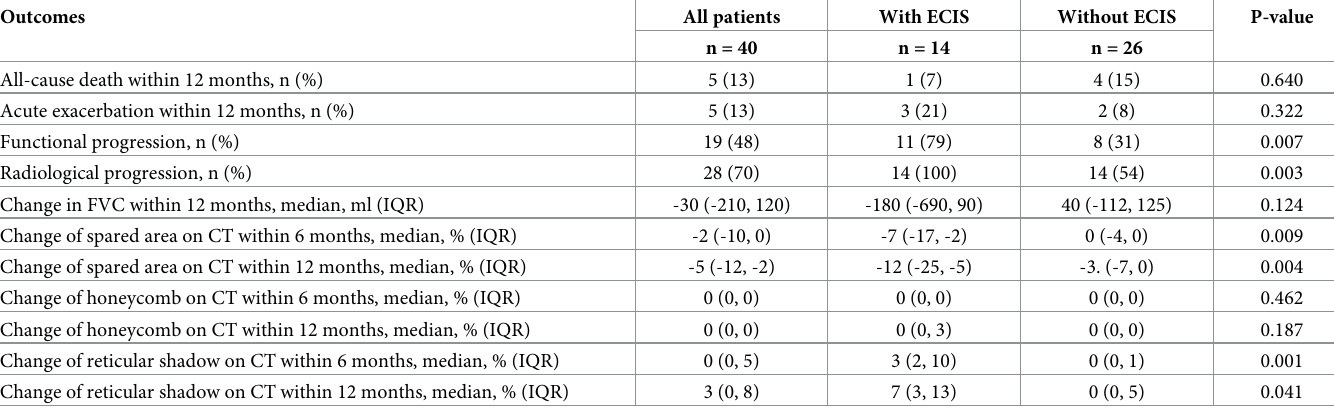
Table 4. Outcome comparison in patients with or without